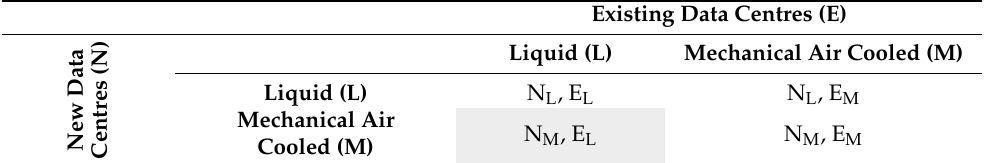
Table 2. Taxonomy of energy efficiency technology adoption